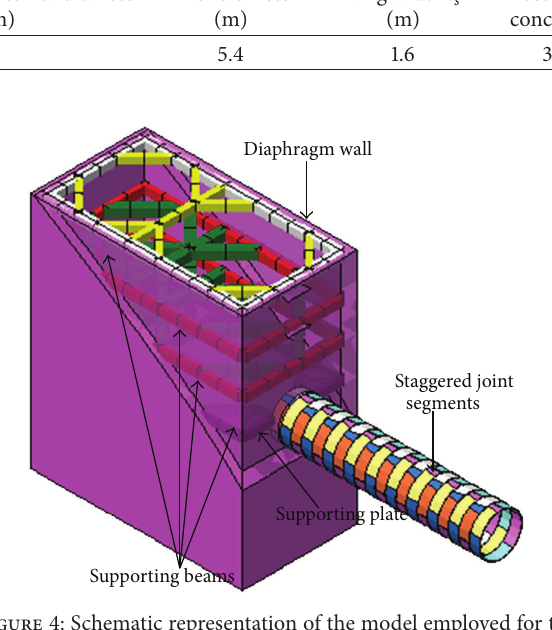
Figure 6: A graph of segment opening relative to joint number.